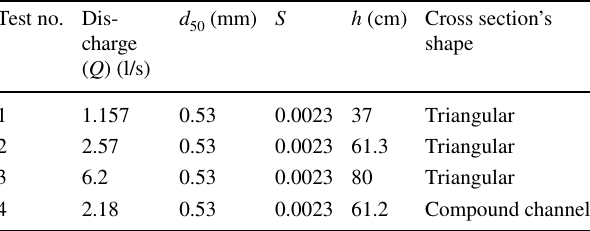
Table 1 Different experiment characteristics Test no. Dis- charge